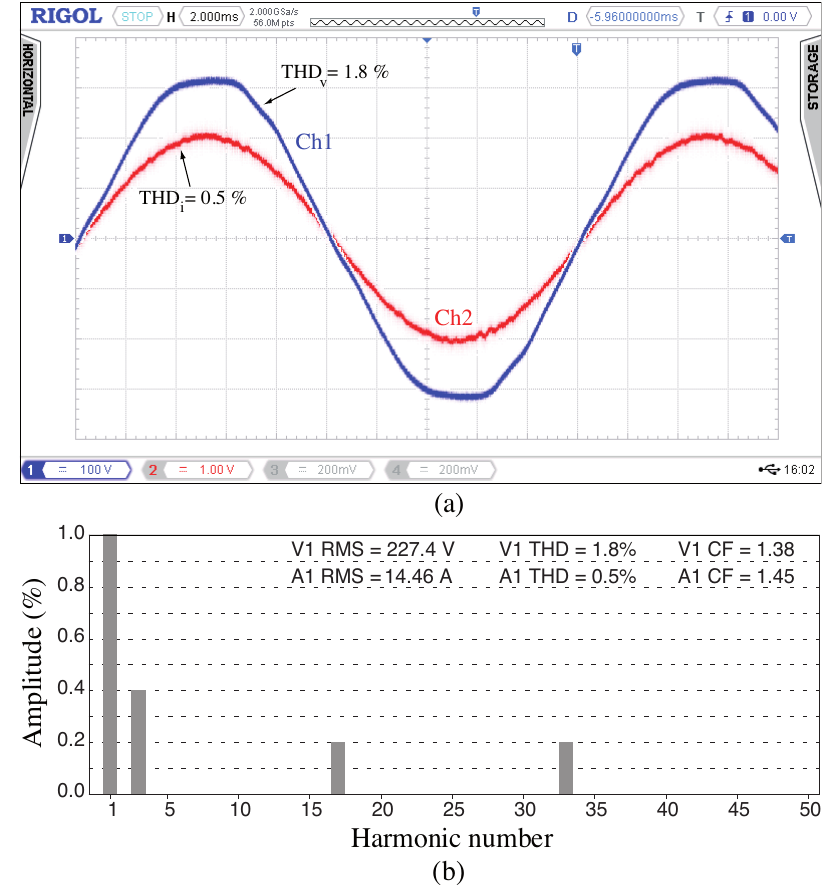
Figure 11. Grid current at nominal 10 kVA using the IPCC control with CE: ( a ) grid voltage (Ch1: 100 V/div) and grid current (Ch2: 10 A/div); and ( b ) harmonic content of the grid